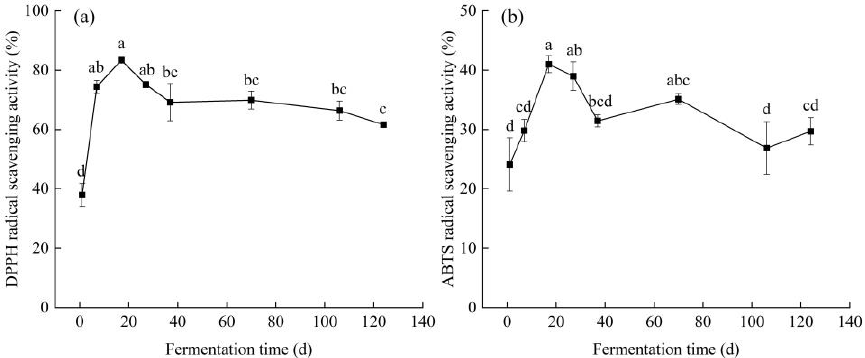
Figure 3. ( a ) DPPH radical scavenging activity and ( b ) ABTS radical scavenging activity of edible grass during fermentation. The bars with different letters indicate significant differences ( p < 0.05).